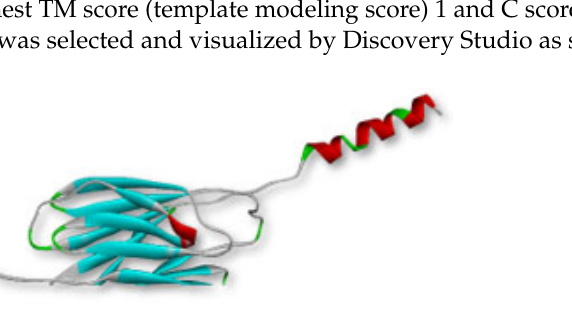
Figure 1. The tertiary structure of MPXVgp169 virulent protein.